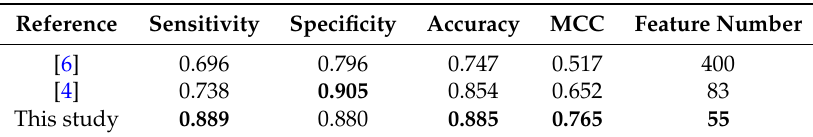
Table 6. Performance comparisons with the existing methods on the training dataset by the jackknife cross validation, where better results are highlighted in bold.